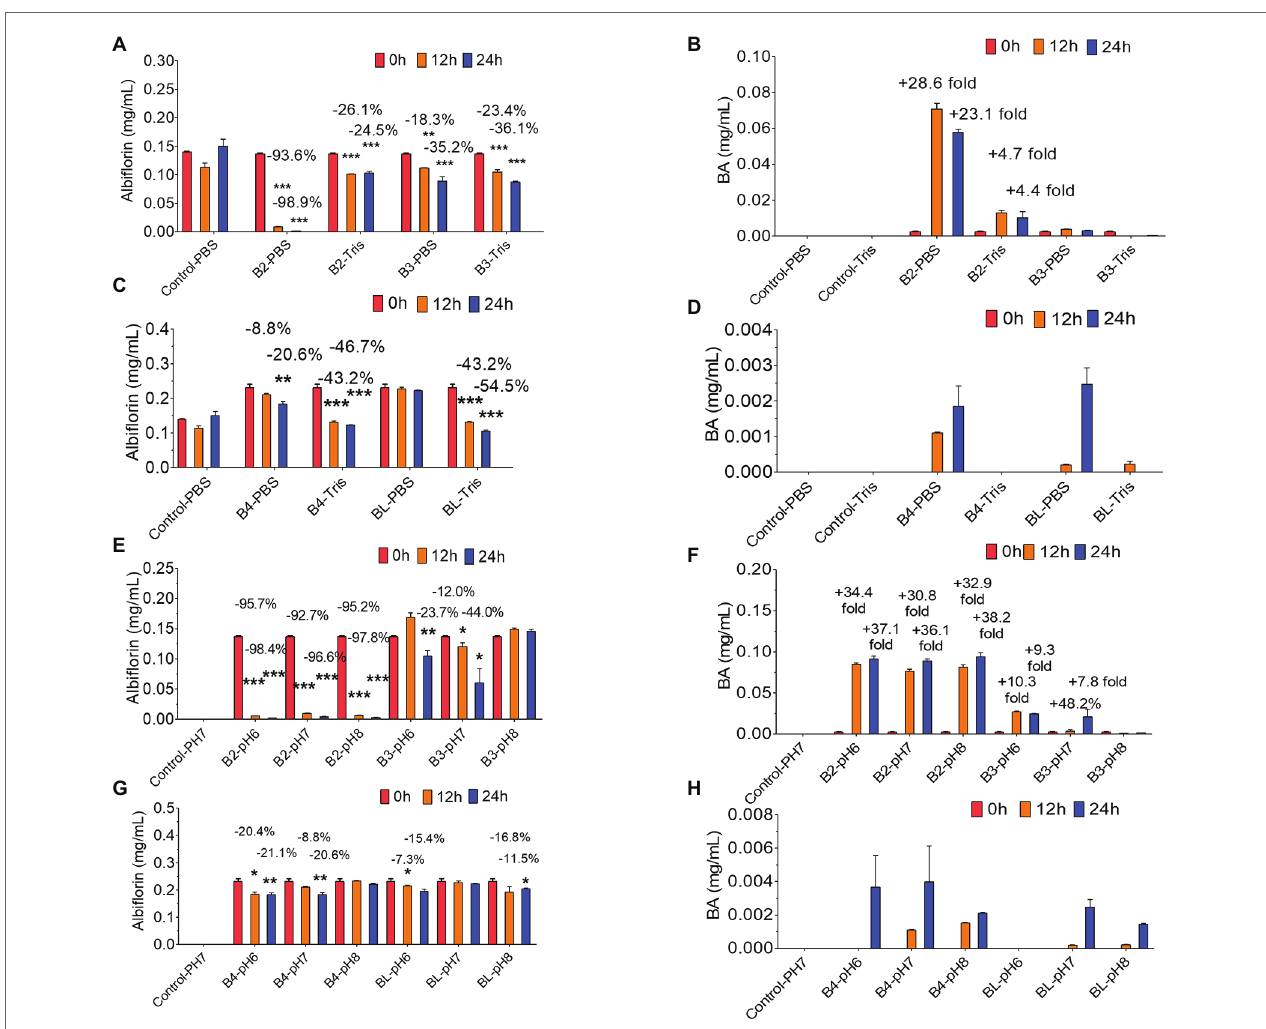
FIGURE 4 | Albiflorin metabolism by four esterases (B2, B3, B4, and BL) under different conditions. (A) Conversion of albiflorin by B2 and B3 in PBS and Tris-HCl buffer. (B) Benzoic acid (BA) generated by B2 and B3 in PBS and Tris-HCl buffer. (C) Conversion of albiflorin by B4 and BL in PBS and Tris-HCl buffer. (D) Benzoic acid (BA) generated by B4 and BL in PBS and Tris-HCl buffer. (E) Conversion of albiflorin by B2 and B3 at pH 7.0, 8.0, and 9.0. (F) Benzoic acid (BA) generated by B2 and B3 at pH 7.0, 8.0, and 9.0. (G) Conversion of albiflorin by B4 and BL at pH 7.0, 8.0, and 9.0. (H) Benzoic acid (BA) generated by B4 and BL at pH 7.0, 8.0, and 9.0 (Student’s t -test, * p < 0.05, ** p < 0.01, and *** p < 0.001, data are expressed as the mean ±